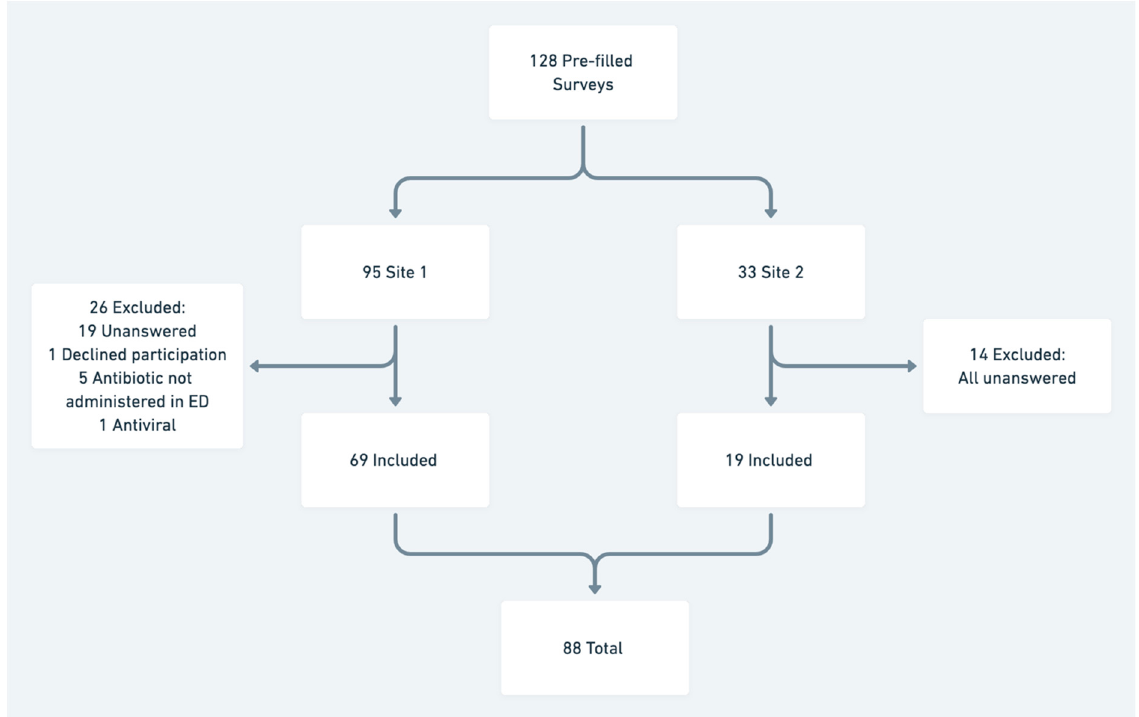
Figure 1. Flow chart of included participants.